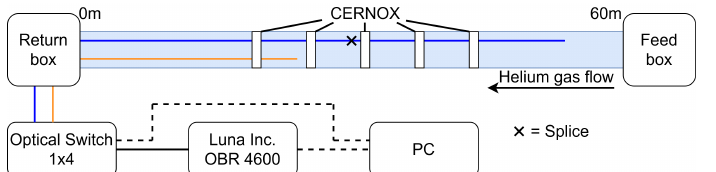
Figure 8. Schematic representation of the SC-Link setup. Dashed lines represent electrical connections, the colored lines represent different fiber samples: blue = Acrylate250 (55 m), orange = PEEK400 (24 m). The fibers were placed inside the SC-Link cryostat starting from the return box. The fibers were monitored by a Luna Inc. OBR4600 through an optical switch. A PC synchronized the OBR and the